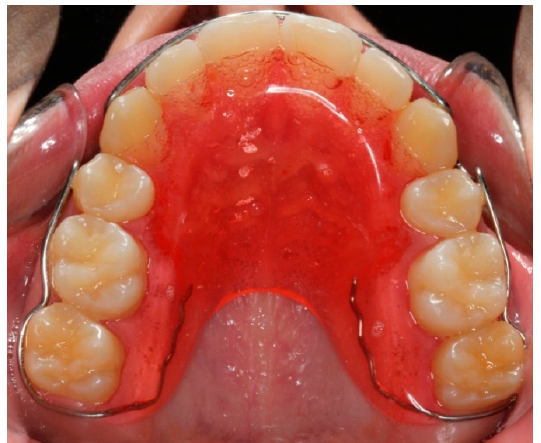
Figure 3. Wrap Around removable